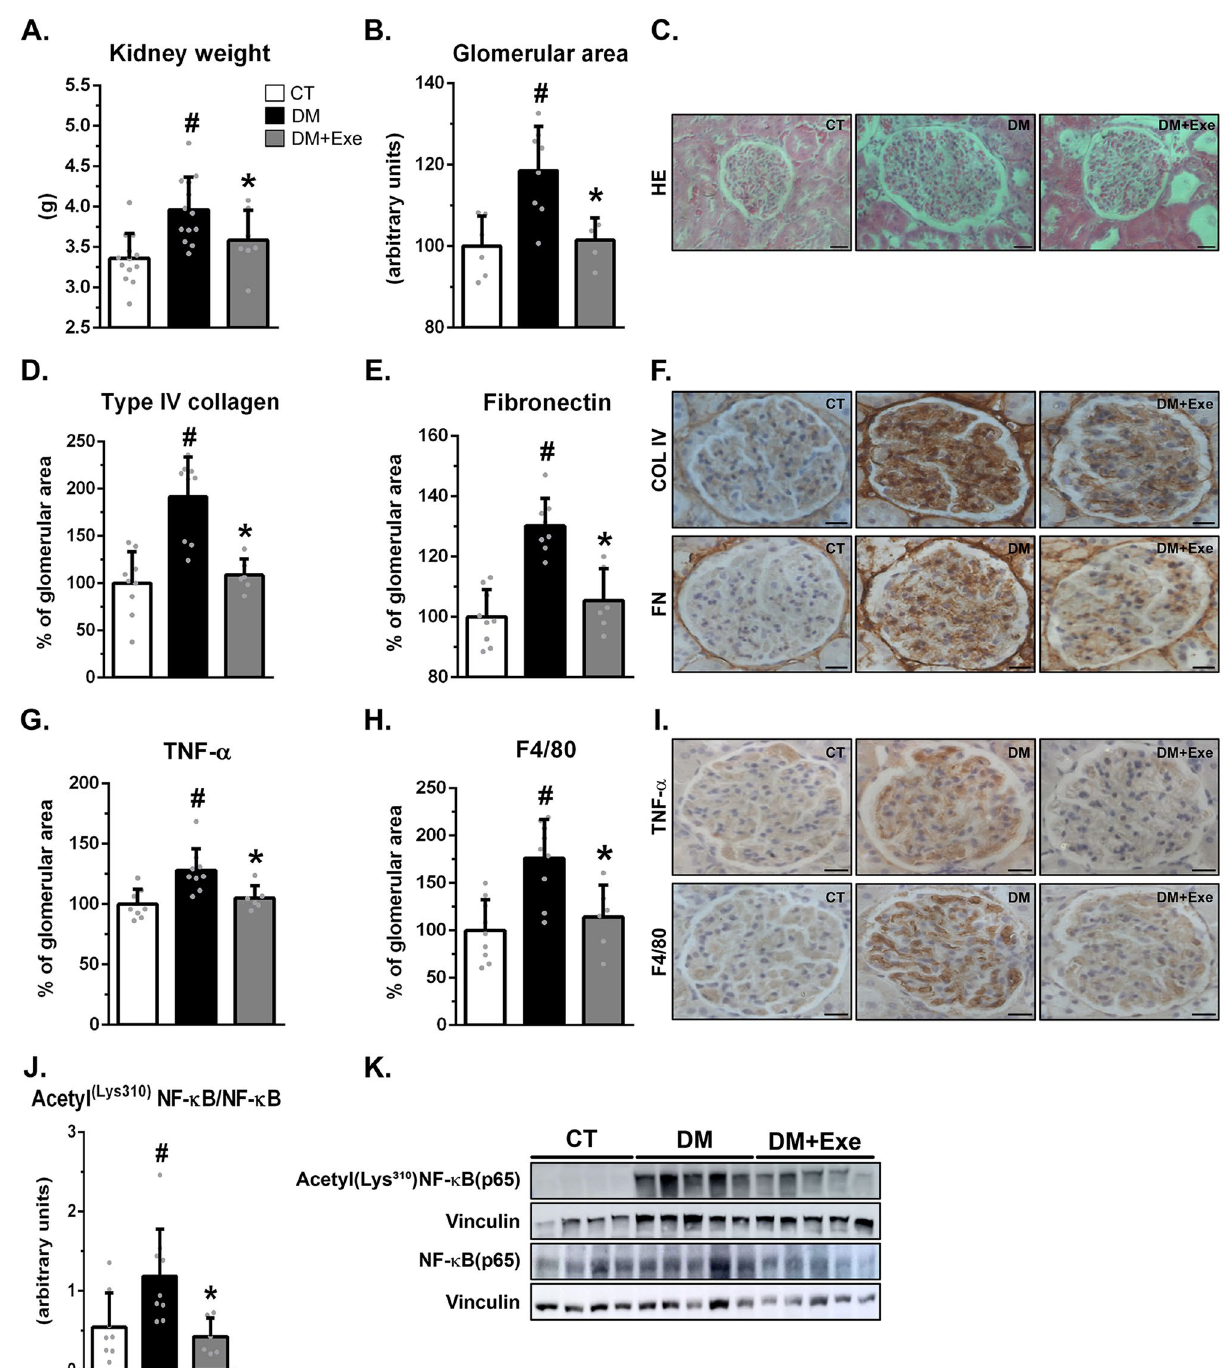
Figure 1. Eight weeks of aerobic physical exercise in diabetic rats prevented markers of diabetic nephropathy. ( A ) Kidney weight. ( B ) Graphical quantitation of the glomerular area. ( C ) Representative photomicrography of renal tuft stained with HE (magnification: × 630). ( D , E , G , H ) Graphical quantitation of immunohistochemistry for type IV collagen ( D ), fibronectin ( E ), TNF-α ( G ), and macrophage infiltration (F4/80, H ). ( F , I ) Photomicrography of glomerular immunohistochemistry for type IV collagen and fibronectin ( F ) and TNF-α and F4/80 ( I ) (magnification: × 630). ( J , K ) Western blot analysis of acetyl(Lys 310 )NF-κB(p65) in the renal cortex ( K ), followed by quantitation of acetyl(Lys 310 )NF-κB(p65)/vinculin ratio ( J ). Blots are representative of three independent experiments. Results are means ± SE. CT, nondiabetic; DM, sedentary diabetic; DM + Exe, exercised diabetic. HE, hematoxylin eosin; col IV, collagen IV; FN, fibronectin; F4/80, marker of macrophage infiltration. # p < 0.05 vs. CT; * p < 0.05 vs. DM. Scale bars = 20